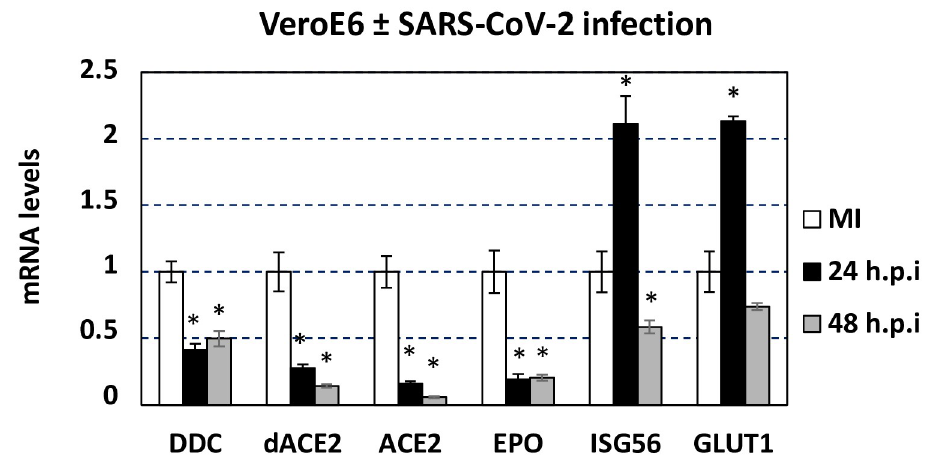
Fig 8. Effect of SARS-CoV2 infection in DDC , dACE2 , ACE2 , EPO and ISG56 gene expression in vitro . VeroE6 cells were inoculated with the SARS -CoV-2 isolate 30–287 of lineage B1. Mock-infected (MI) cells were cultured in parallel, as control. 24 and 48 hours post-infection cells were lysed and cell lysates were analyzed using RT-qPCR. YWHAZ mRNA levels were used for normalization. Bars represent mean values from three independent experiments in triplicates. Error bars indicate standard deviations. � p < 0.001 vs MI cells (Student’s t test).